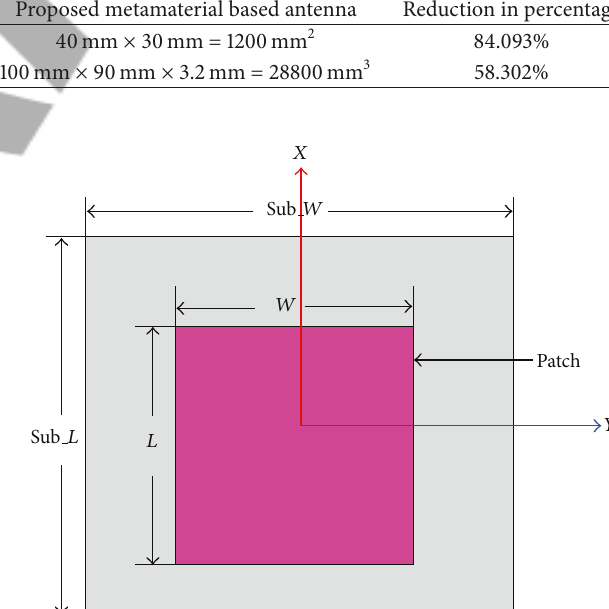
Figure 6: VSWR v/s frequency plot for dual-band proposed patch antenna.